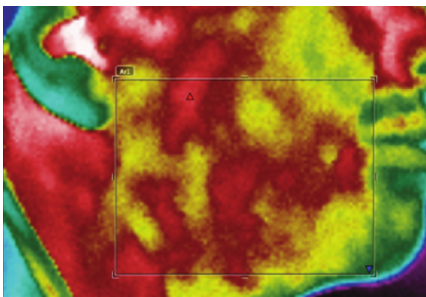
Figure 19: Temperature measurement of the face returned to its normal temperature after the temperature was increased.